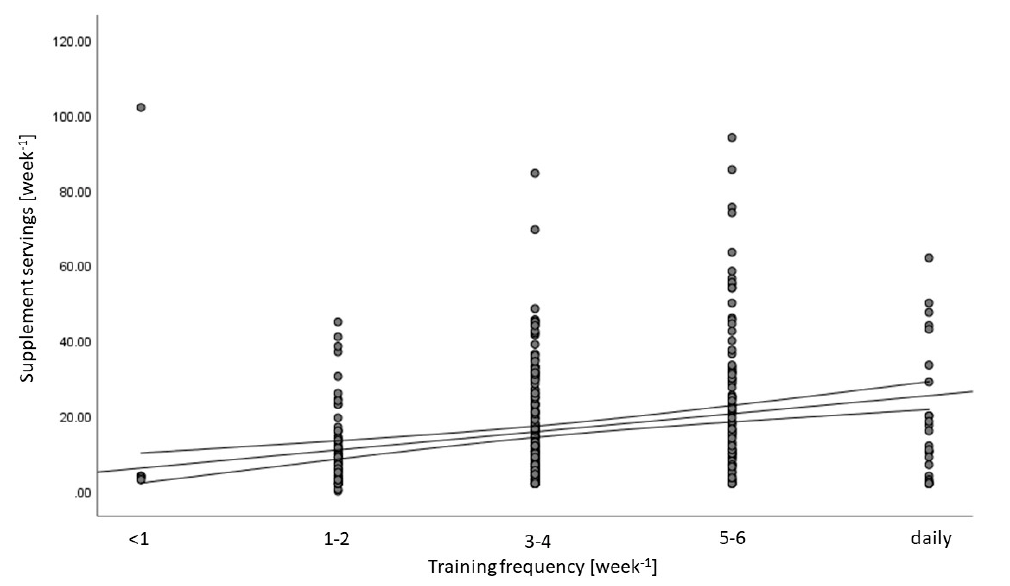
Figure 1. Supplement intake vs. training frequency. The scatter density plot and spearman rank correlation (mean and 95% confidence interval) of supplement servings per week vs. training frequency give an r s = 0.253 ( p < 0.001).